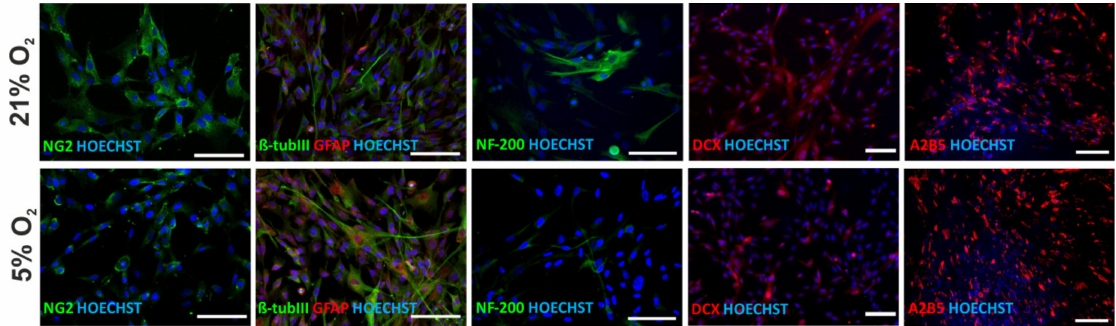
Figure 7. Neural differentiation potential of hWJ-MSCs cultured under 21% O 2 and 5% O 2 (passage 2). Fluorescent images showing the expression of markers of neural progenitors (NG2, A2B5), glial (GFAP), and neuronal ( β -tubIII, DCX, NF-200) cells in Wharton’s jelly-derived human mesenchymal stem cells. Representative images of the cells isolated from WJ-MSC (2) donor are presented (scale bars: 100 µ